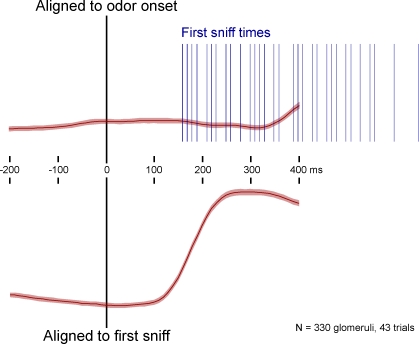
Inhalation Is Required for Odorant-Evoked Activation of Olfactory Receptor NeuronsTraces show averaged, normalized optical signals from responding glomeruli in each of 43 trials in which there were no inhalations from 100 ms prior to odorant onset to at least 150 ms after odorant onset. Top trace shows average signal after aligning each trace to the time of odorant onset. The time of first inhalation for each trial is indicated by a vertical line. Bottom trace shows the same data but aligned to the time of inhalation onset. Shaded area indicates standard error. There is no increase in either signal amplitude or variance around the time of odorant onset (top), but there is a clear increase beginning approximately 100 ms after inhalation (bottom).